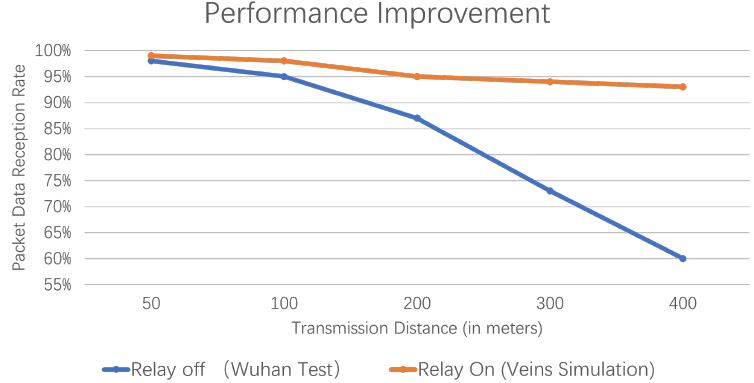
Figure 7. Data reception rate performance improvement with relation to transmission